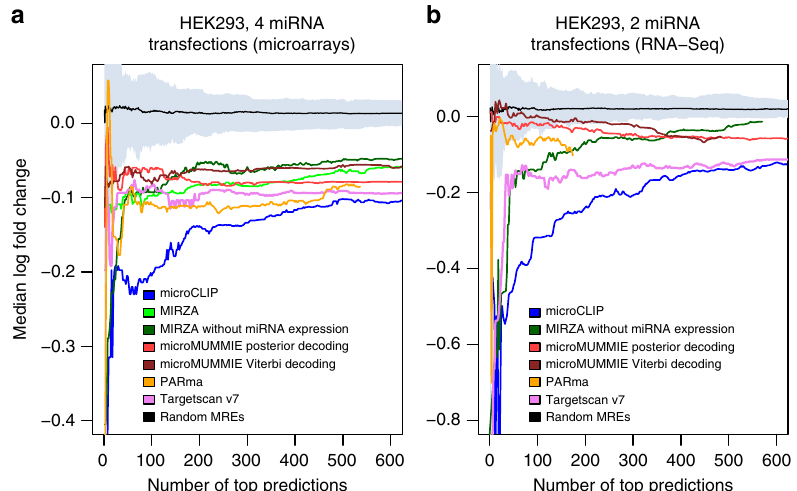
Fig. 6 Assessment of microCLIP prediction ef fi cacy against MIRZA, microMUMMIE, PARma, and Targetscan v7. miRNA-target pairs for each AGO-CLIP in silico approach were obtained from the analysis of 7 PAR-CLIP HEK293 libraries and functional investigation was performed by measuring mRNA responses to miRNA perturbations. Uni fi ed sets of a 4 microarray and b 2 RNA-Seq datasets, in which miRNAs were individually transfected into HEK293 cells, were included in the evaluation process. Median fold-change values (log 2 ) of the top predicted targets per tested algorithm were plotted and accordingly compared by applying stepwise cutoffs on total predictions. Performed comparisons additionally incorporate a group comprising mean fold changes of 1000 randomly selected genes (without replacement) by using 100 re-samplings. The gray shaded area represents the minimum-to-maximum log 2 fold-change range of the re-samplings per number of top predictions. microCLIP signi fi cantly outperforms all the juxtaposed implementations, detecting targets with the strongest median downregulation, from stringent to loose prediction thresholds (two-tailed Wilcoxon signed-rank